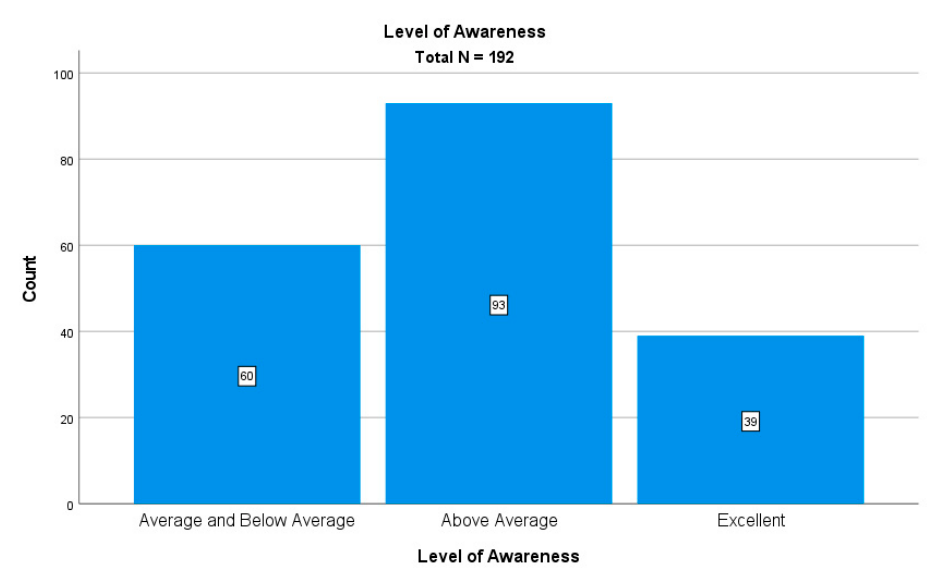
Figure 1. Participants’ rating of their level of awareness. The majority of respondents believed that the incubation period of COVID-19 is 5–14 days, and the virus can survive on an inanimate object for 72 h (Figures 2 and 3). Regarding the level of awareness, the proportion of participants who attended semi- nars and rated their knowledge as above average and excellent was 73%. Therefore, those who attended seminars considered themselves more aware than those who did